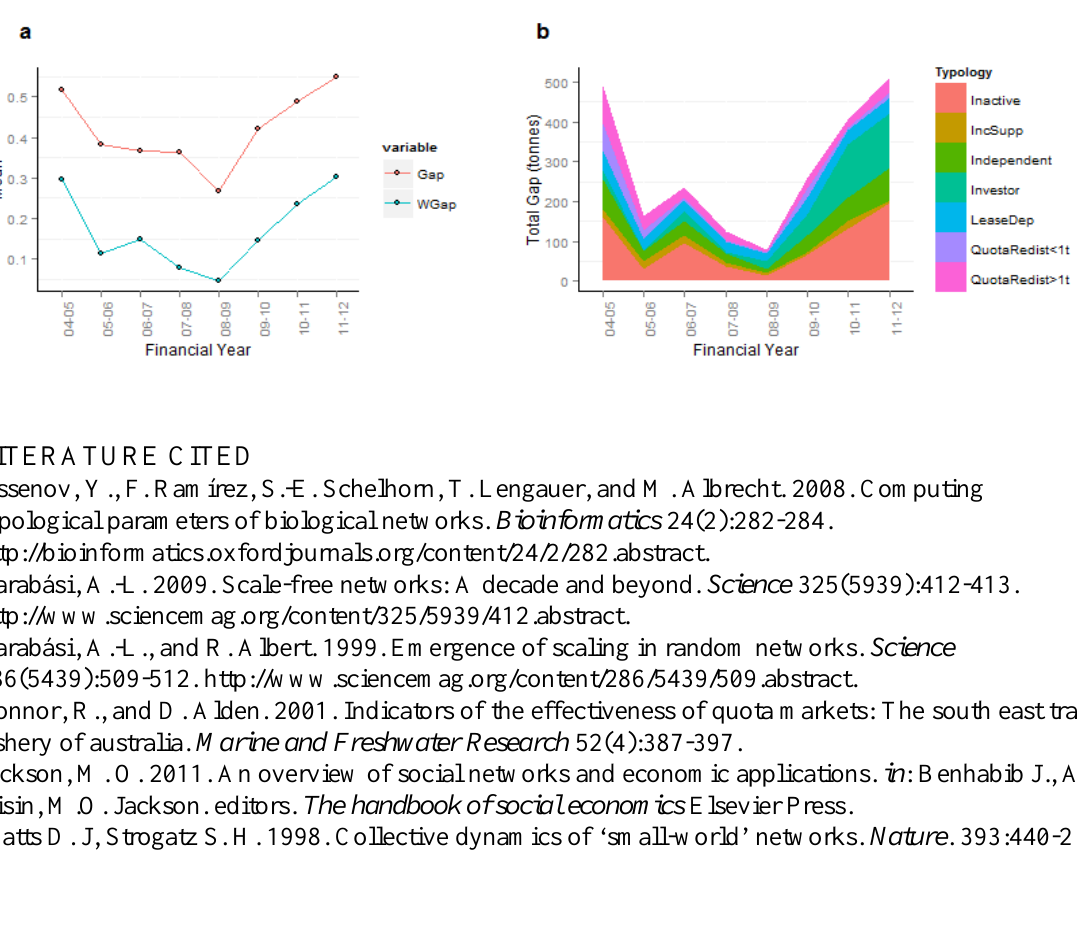
Fig. A1.1. a) evolution of average gap (Gap) and gap weighted by proportion of TAC held (WGap) over time, b) total unused quota at the fishery level in absolute values